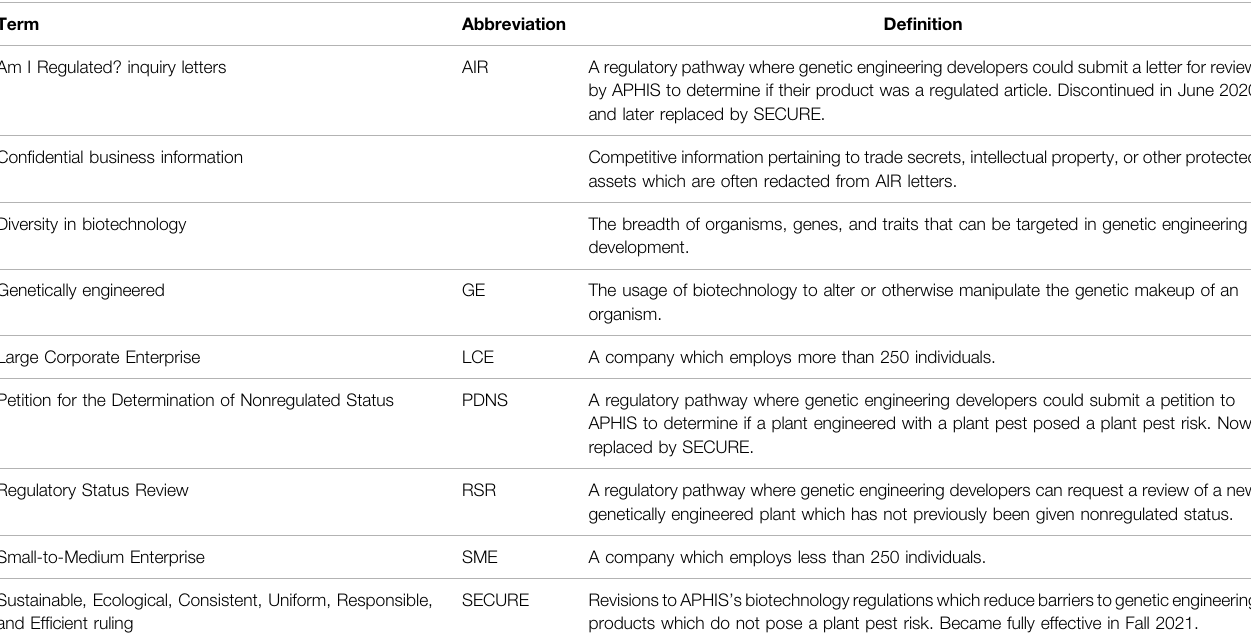
TABLE 1 | De fi nitions of terms used in this